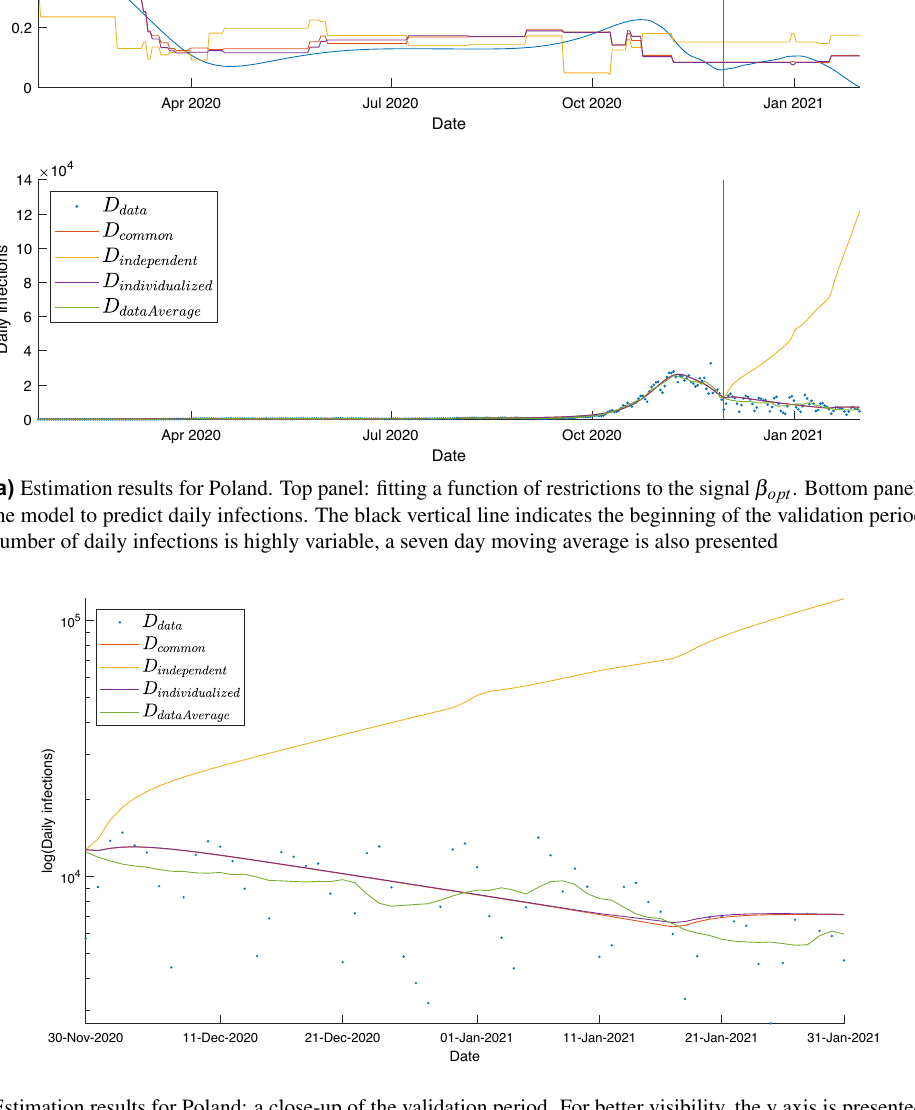
(b) Estimation results for Poland: a close-up of the validation period. For better visibility, the y axis is presented as a log scale. Blue points represent daily infections, the green line is a 7-day moving average. The common and individualized approaches (red and purple, respectively), are able to predict infections quite accurately, and the independent model (yellow line) considerably deviates from the observed data. Figure 6. Prediction